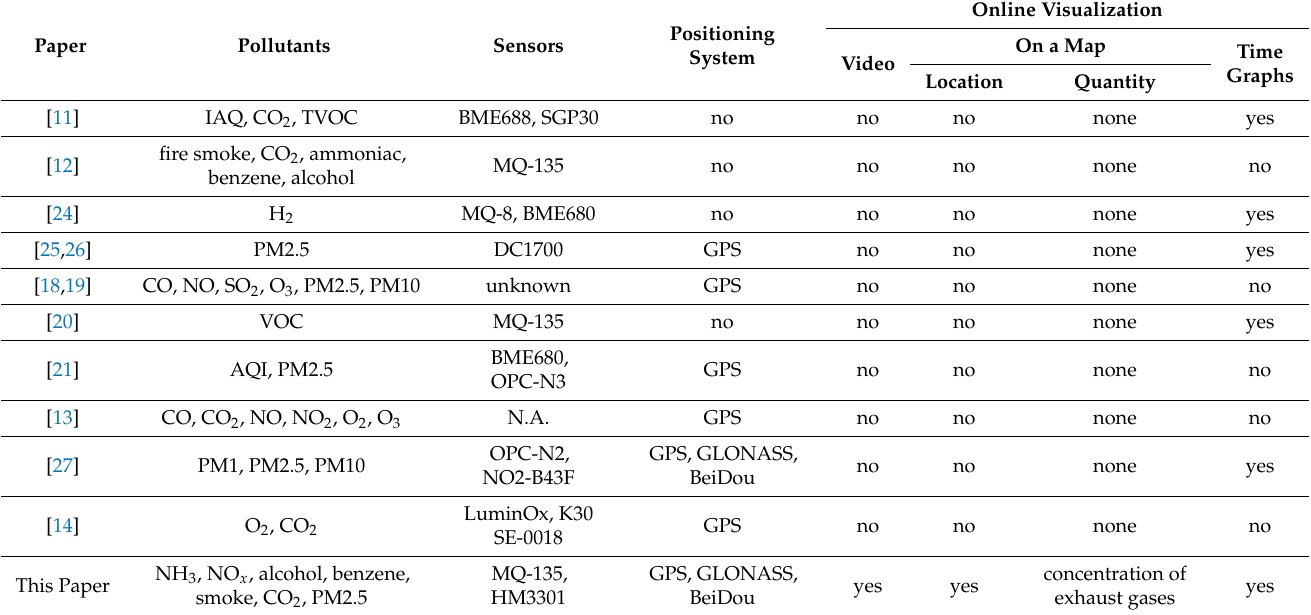
Table 7. Comparison of the Kestrel with related